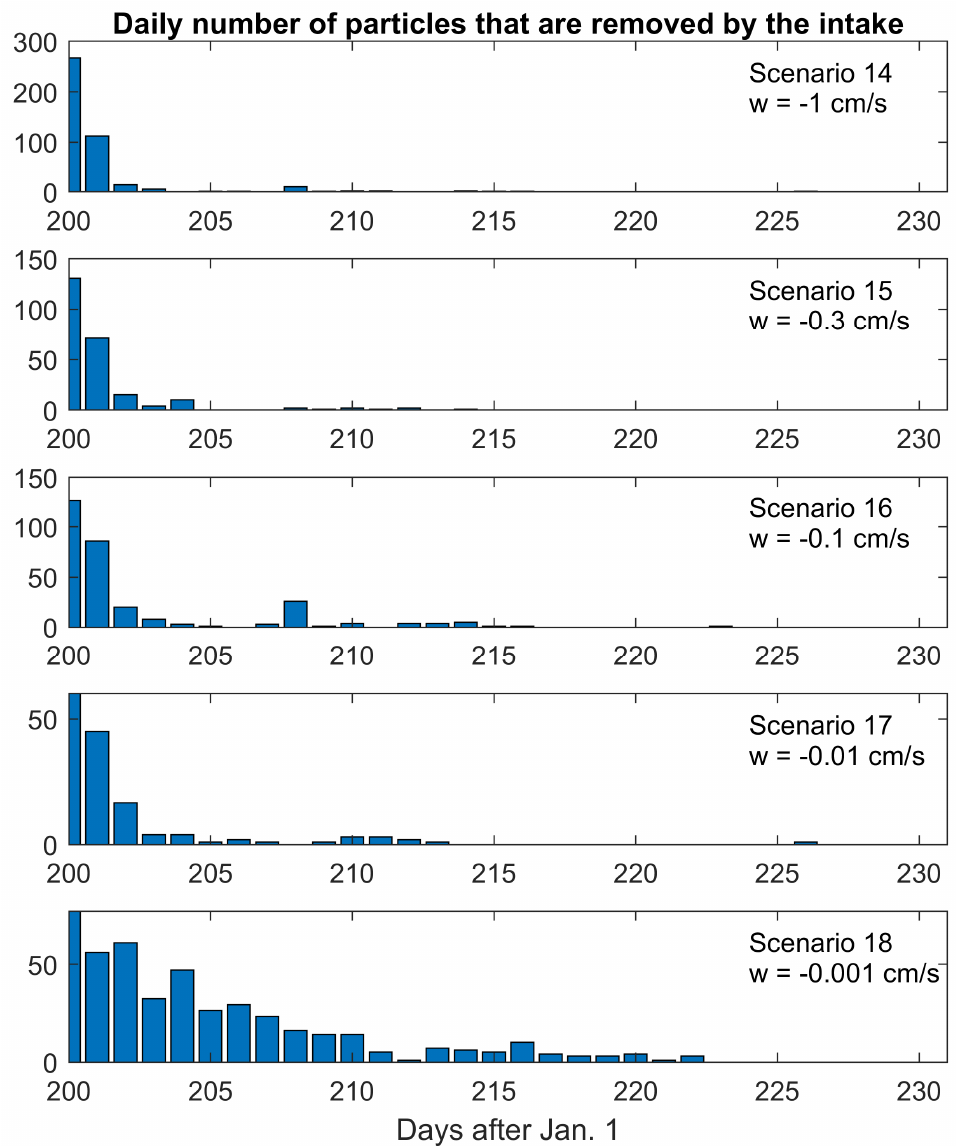
Figure 8. Daily statistics of the number of particles that are removed by the intake for scenarios 14– 18, where the release location is around the intake. where the release location is around the